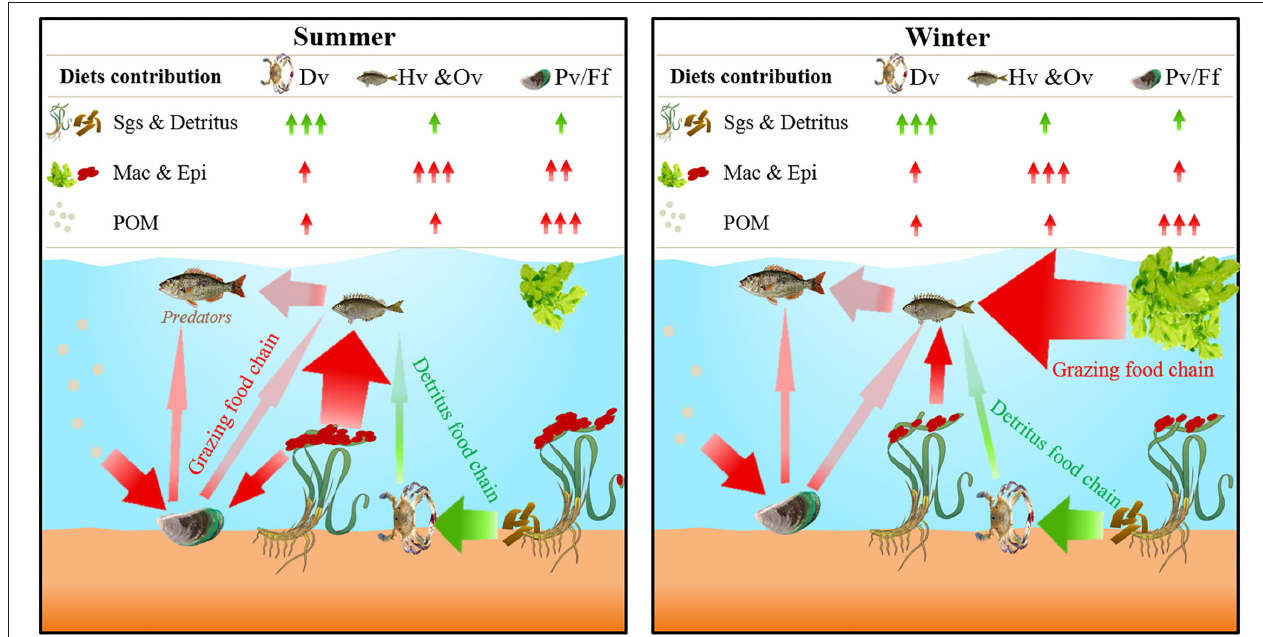
FIGURE 5 | Conceptual summary of findings for the carbon transfer process of food web and trophic pathway in a eutrophic tropical seagrass meadow.